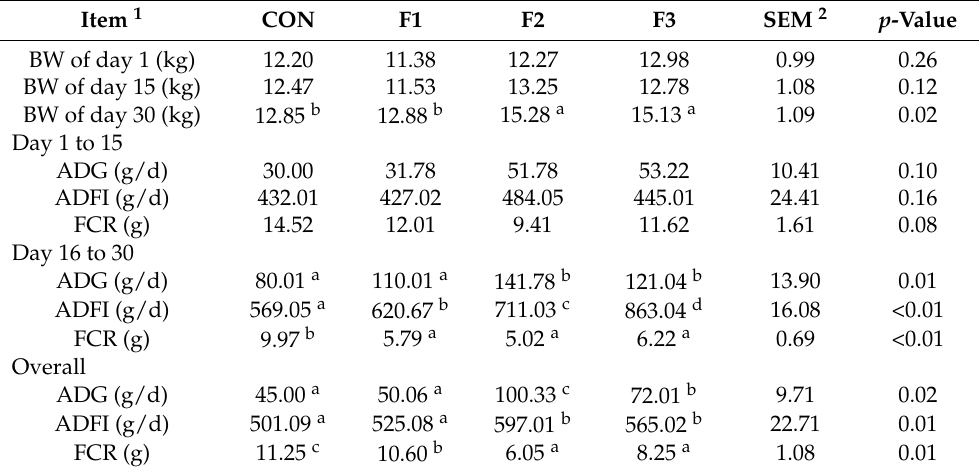
Table 2. Effects of fucoidan administration on growth performance in weaned kids.